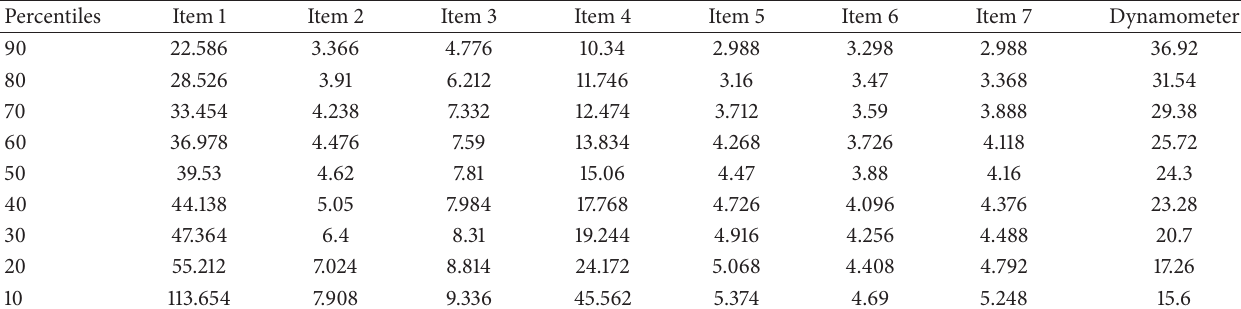
Table 6: 𝑛 = 15 , males, 6–19, nondominant hand, educational instruction: attending elementary school.